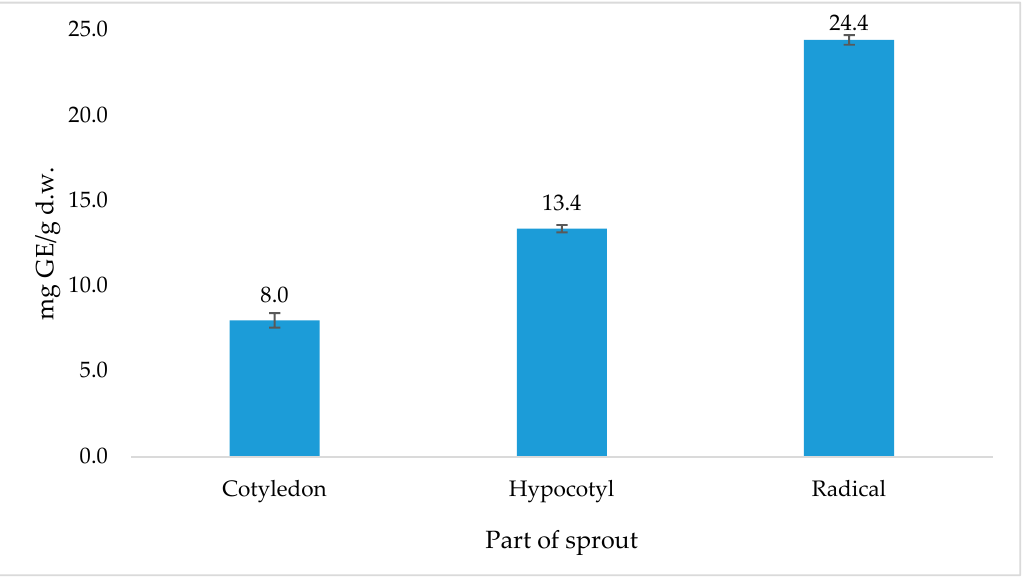
Table 3. Central composite design of actual factors and responses based on actual and predicted values.